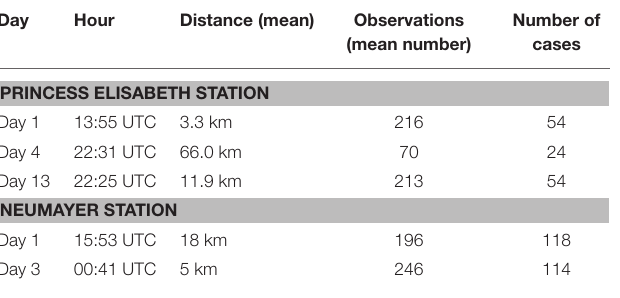
TABLE 2 | Overview of the overpasses at Princess Elisabeth and Neumayer stations.